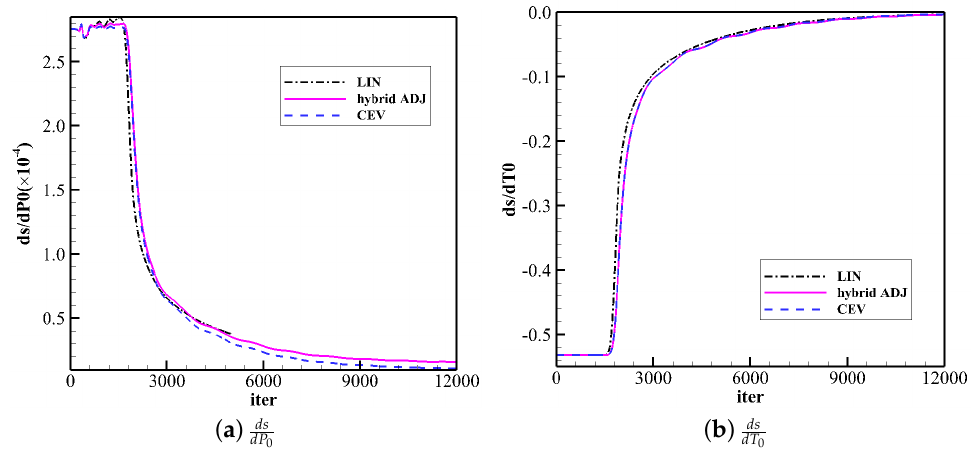
Figure 24. Comparison of sensitivity convergence histories for the Aachen